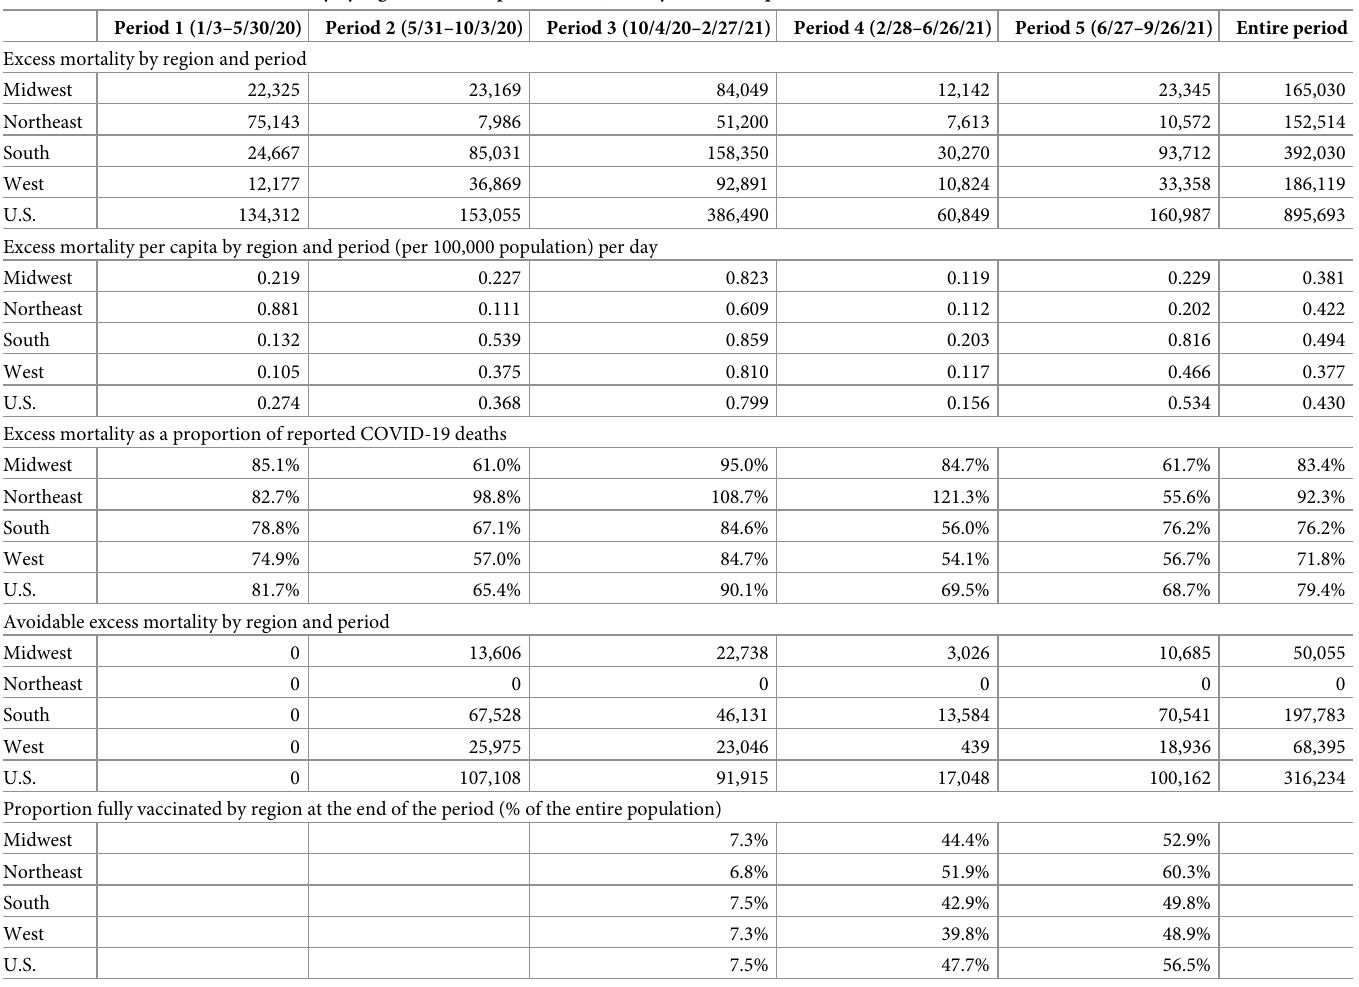
Table 1. Excess and avoidable mortality by region and time period, U.S., January 3, 2020 –September 26,